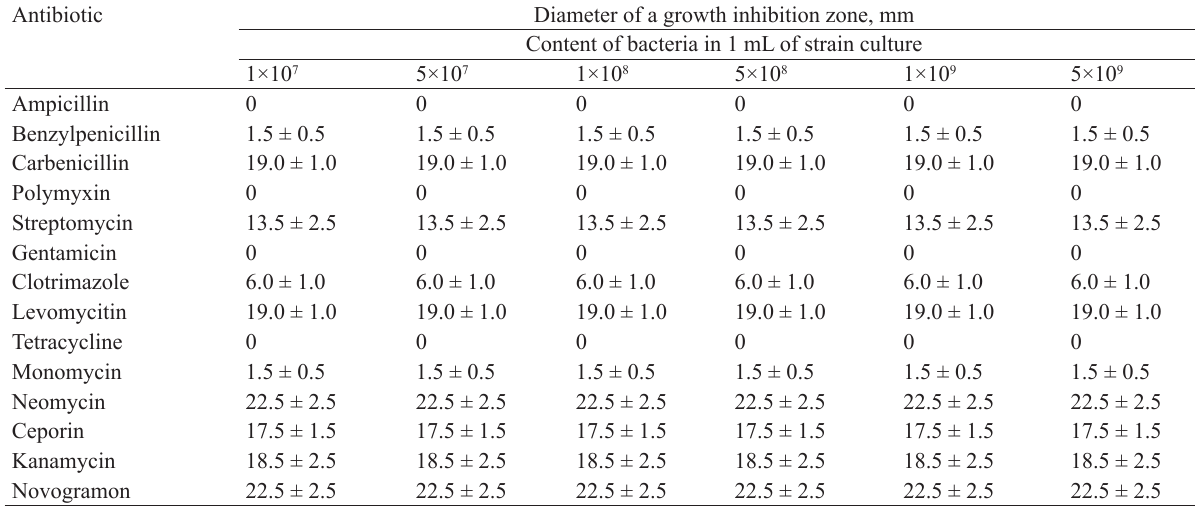
Table 2 Antibiotic resistance of Bacillus subtilis isolate Antibiotic